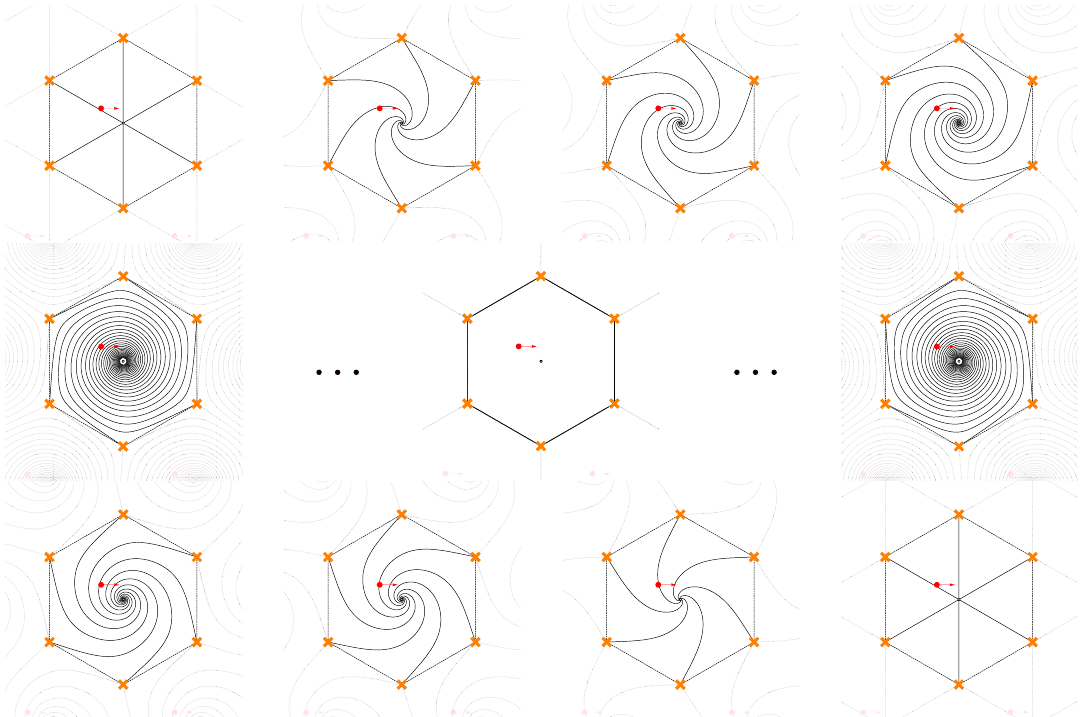
Figure 15. Sequence of spectral networks of the SU(2), N = 2 (cid:3) theory, presented as a glued hexagon. The phases begin with sector I as described in (3.22), for phases ranging from # c (cid:0) (cid:25)= 2 (top-left) up to # c (center), and proceeds with phases from sector II as described in (3.25) ranging from # c to # c + (cid:25)= 2 (bottom-right).